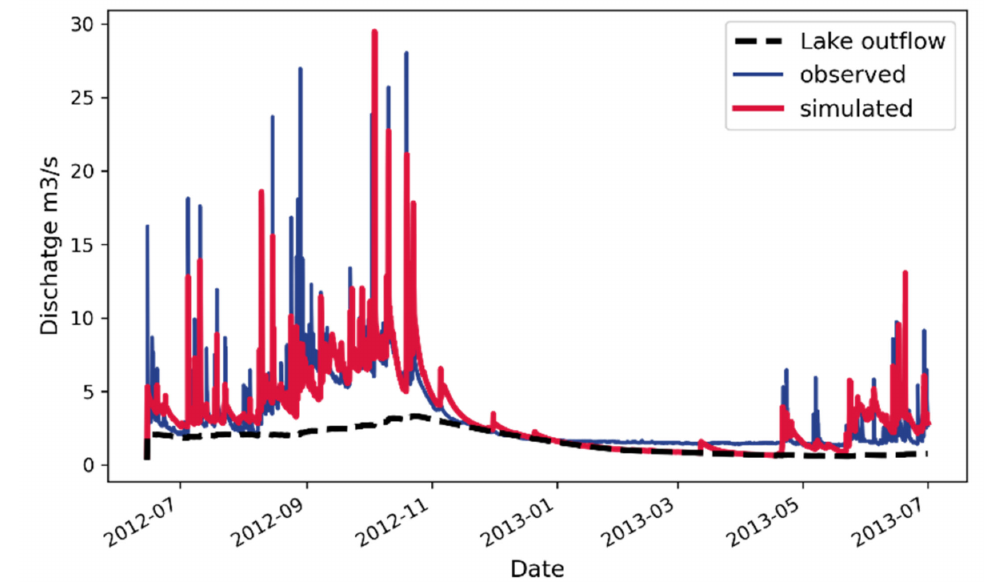
Figure 17. Contribution of the lake outflow in the whole hydrograph at the